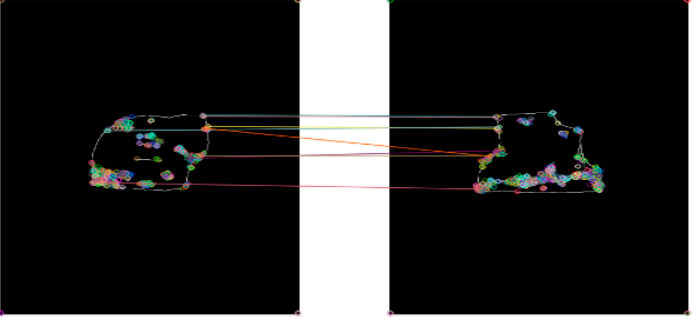
Figure 7. Binarized ORB feature matching.